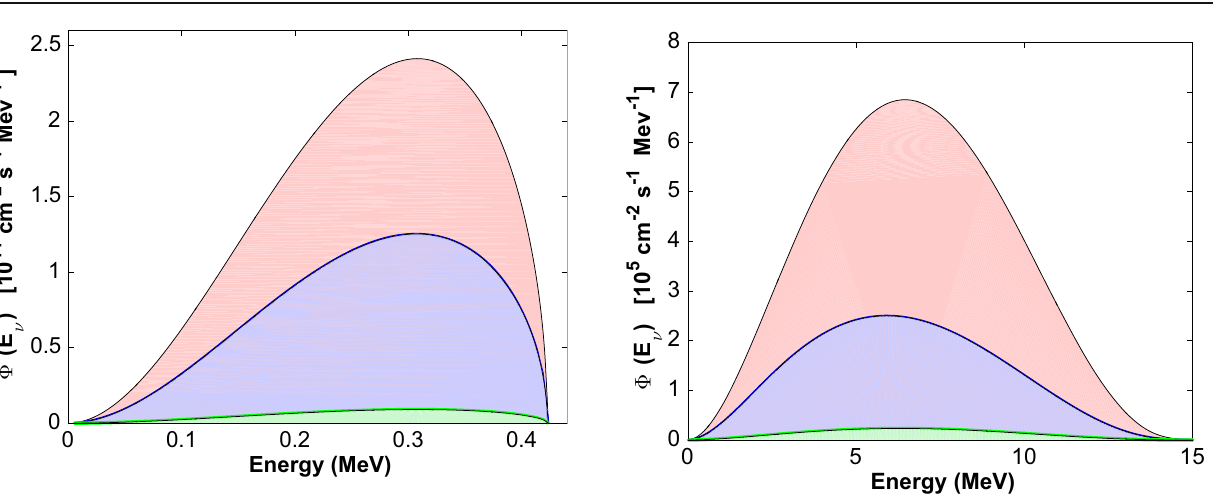
Fig. 7 Neutrino spectrum of 8 B nuclear reaction. The colour scheme is the same used in Fig. 5